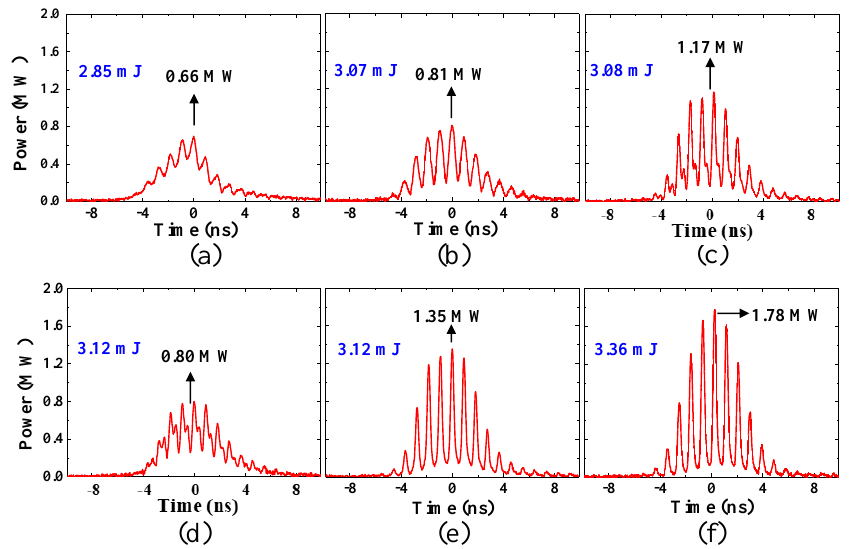
Figure 2. ( a – f ) Mode-locked Q-switched pulses with various temporal profiles in the test energy range from 2.9 to 3.4 mJ. In order to determine the threshold of peak-power intensity and energy density for the initial breakdown under continuous-firing operation at a repetition rate of 0.2 Hz after warm-up, hundreds of mode-locked Q-switched (ML-QS) pulses were tightly focused into the atmospheric air. Note that the temporal profiles of these laser pulses have been monitored pulse-by-pulse to determine the region of threshold fairly. The pulse width of the envelope of ML-QS pulses was 7 ns on average. Figure 3a shows the relation of the successes of air breakdowns to the laser energy and laser peak power with ML-QS laser. The experimental results indicate that the success of the initial breakdown is slightly related to the pulse energy but mainly dominated by the peak power in the energy range from 2.10 to 3.05 mJ, corresponding to an energy density range from 1.36 to 1.98 kJ / cm 2 . To analyze the influence of peak power on air breakdown for the specific laser cavity more explicitly, the statistics on the breakdown probability, ρ , with respect to the peak power, P , was performed in Figure 3b. For determining the threshold peak power, P th , threshold width of peak power, ∆ P , and normalized threshold width of peak power, ∆ (cid:101) P , a phenomenological formula was used to fit the experimental data numerically as